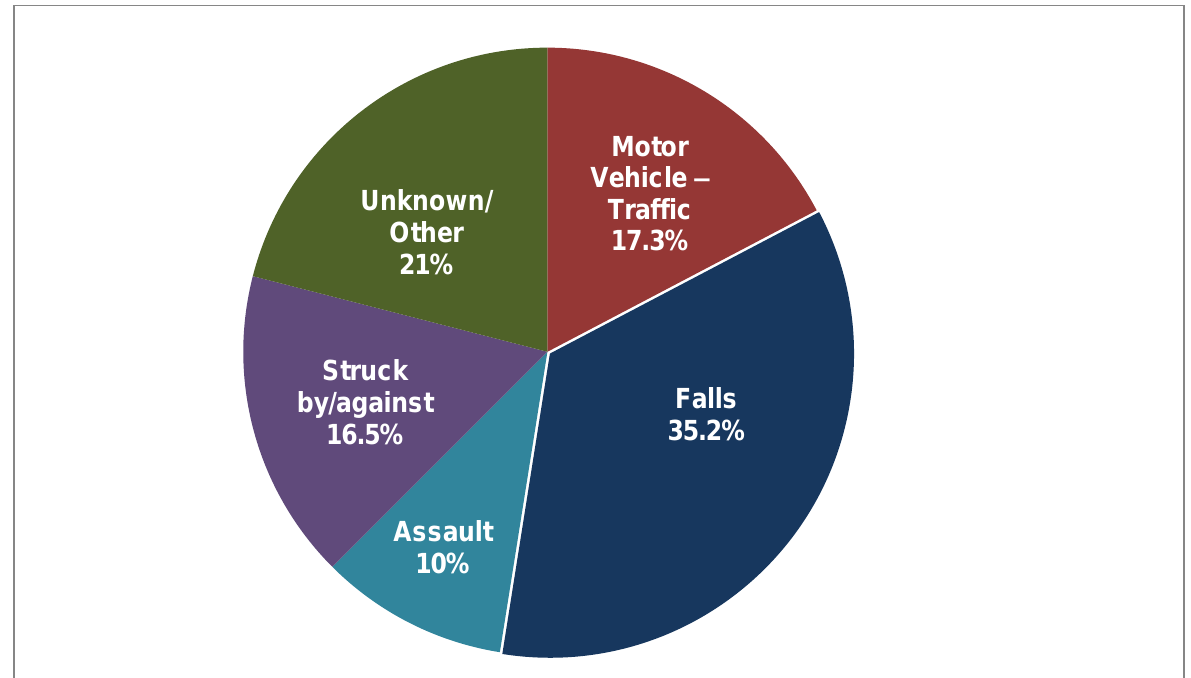
Figure 6. Fatal and Nonfatal Traumatic Brain Injuries either occurring alone or in conjunction with other injuries by Mechanism - US,